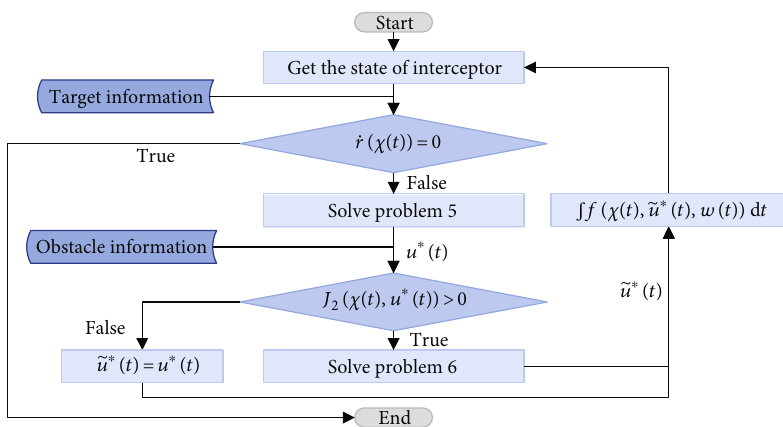
Figure 3: Overall scheme of guidance with obstacle